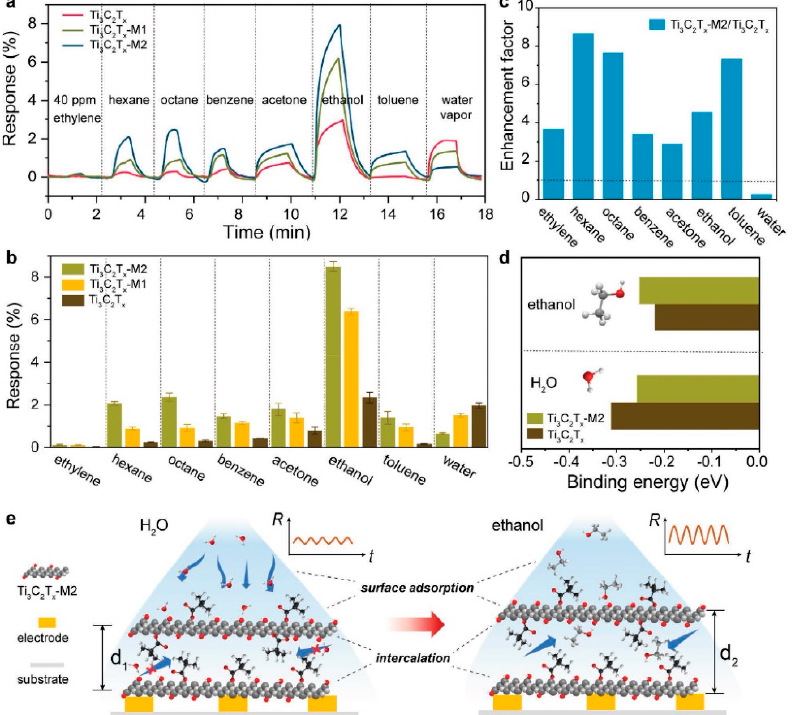
Figure 5. Enhanced VOCs sensing performances and sensing mechanisms of termination-modified Ti 3 C 2 T x . ( a ) The 40 ppm gas response curves and ( b ) equilibrium responses with error bars (N = 3) of pristine Ti 3 C 2 T x , Ti 3 C 2 T x -M1, and Ti 3 C 2 T x -M2 sensors, respectively. Notably, the concentrations marked in figures were approximate values; more details can be found in Table S1, Supporting Information. ( c ) The enhancement factor of Ti 3 C 2 T x -M2 sensor against VOCs and water vapor sensing, calculated by gas responses of Ti 3 C 2 T x -M2 divided by those of pristine Ti 3 C 2 T x . ( d ) DFT simulations for ethanol and H 2 O molecules absorbed on pristine Ti 3 C 2 T x and Ti 3 C 2 T x -M2. ( e ) Schematic illustration of the H 2 O and ethanol sensing mechanism of Ti 3 C 2 T x -M2. R, the resistance of the sensor; t, time. Reprinted with permission from [93]. Copyright 2021: Wiley-VCH GmbH.